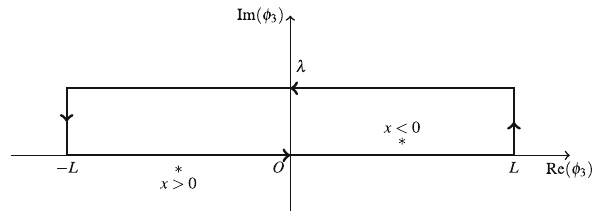
Fig. 4 The contour γ in (A.5). With this contour, one can change the integration contour of φ 3 in (A.4) to that in (A.6), where λ must have the same sign as y for the limit L → ∞ and ε → 0 + . There is a pole at φ 3 = − 1 + i ε shown by ∗ , and only for sgn ( x ) = − sgn ( y ) the x